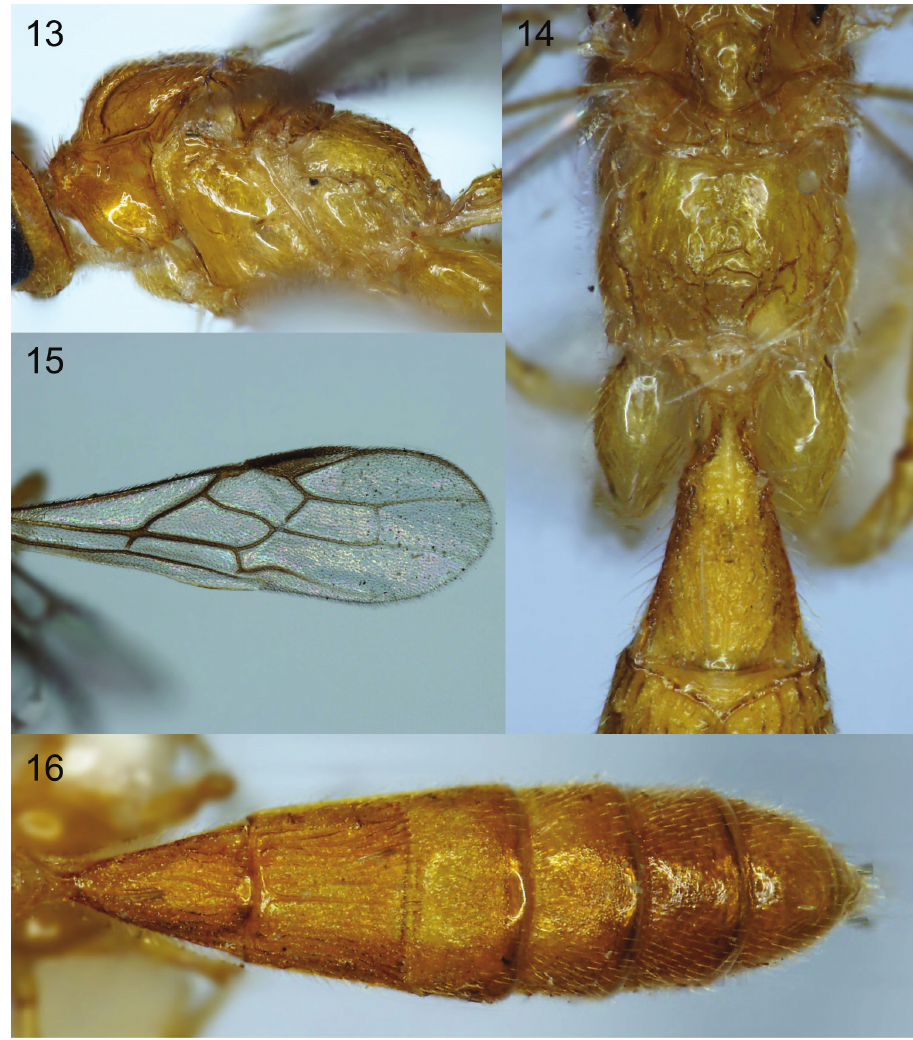
Figures 13–16. Colastomion masalaii sp. n. Cell^D® light photomicrographs. 13 Mesosoma, lateral view 14 propodeum and 1 st tergite 15 fore wing 16